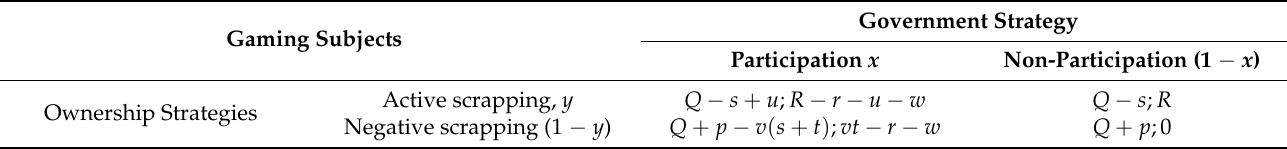
Table 2. The evolutionary game payoff matrix of both